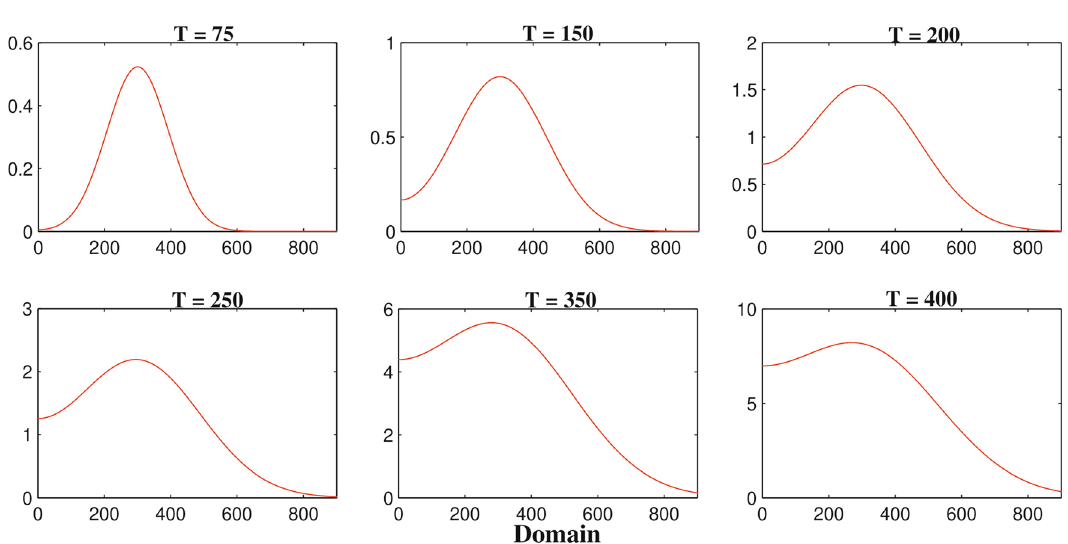
Figure 4. The one-dimensional numerical simulations describe the dynamics of glioma cells density G ( t , x , y ) at times corresponding to 75, 150, 200, 250, 350 and 400 h respectively. The simulation shows the migration of glioma cells density through the domain for an increasing value of time. Parameter values: D G = 55 , D M = 5 , D T = 400 , D C = D I = 25 and the other parameter values and initial conditions are presented in the Table